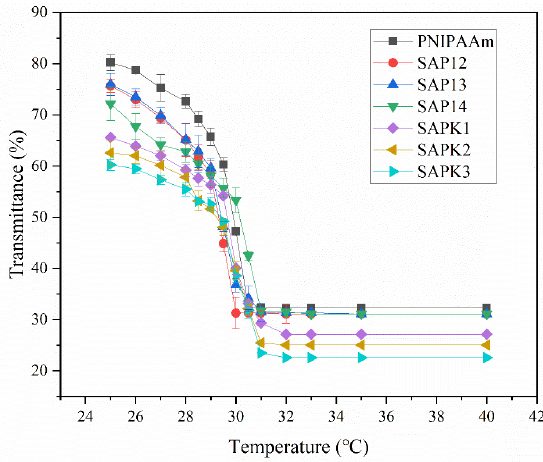
Figure 1. Temperature dependence of transmittance of semi-interpenetrating network (IPN) hydrogels.